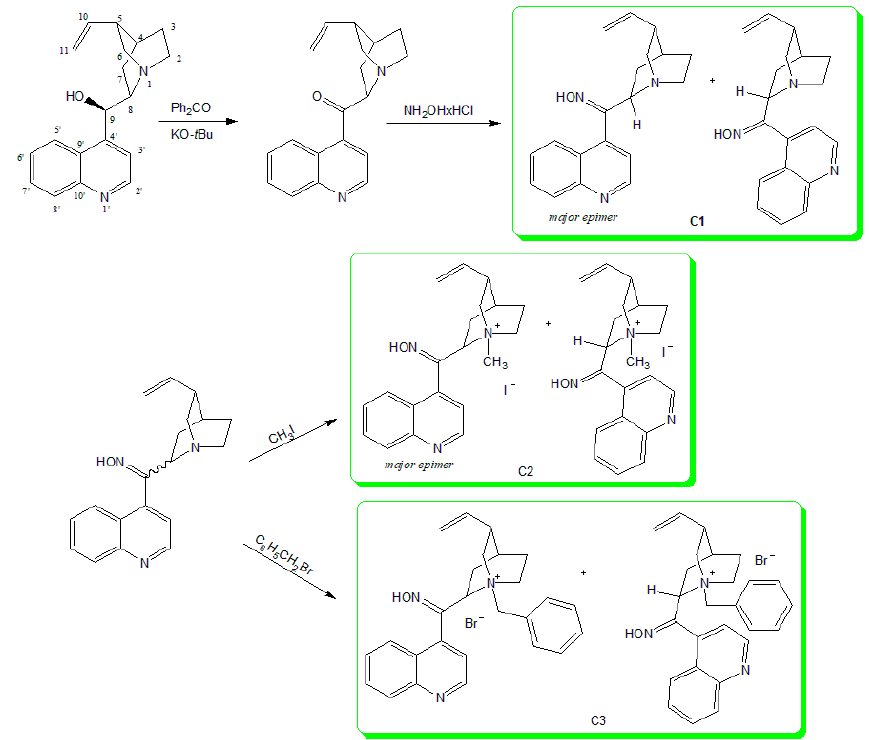
Figure 1. Synthesis of Cinchona derivatives starting from cinchonidine.